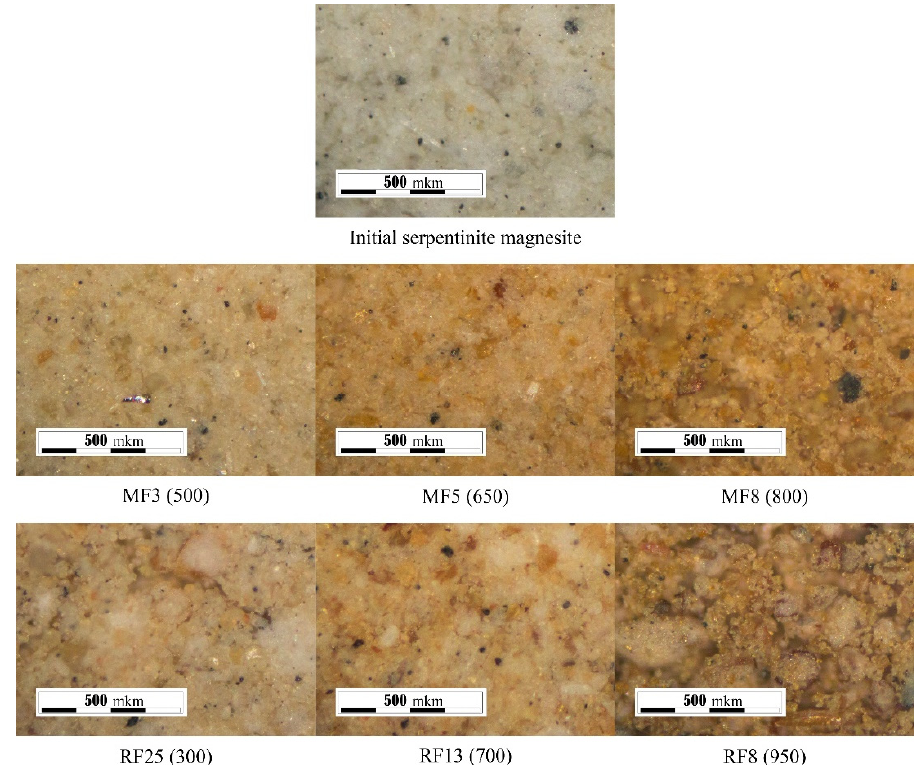
Figure 6. The appearance of serpentine samples obtained in a laboratory muffle furnace (MF) and in a laboratory rotary kiln (RF); the roasting temperature (°C) is indicated in parentheses. The appearance of serpentine samples of the RF series differed from the samples of the MF series (Figure 6); particles from the RF samples appear larger. Particle enlargement was observed during the roasting of serpentines in the industrial apparatus [41]. The par- ticle size increased due to adhesion during the stirring of the material in a rotating tem- perature chamber during heat treatment. The darkest in color sample RF8, obtained at a temperature of 950 °C included a more significant amount of dark gray particles that corresponded to magnetite; the presence of this phase in the samples of the RF series was confirmed by XRD data (Figure 1b). 3.3. Determination of the Thermally Activated Serpentine Sample Color Parameters using Various Models Firing serpentines led to a change in color characteristics (RGB, Lab). The combina- tion of these characteristics for each obtained sample corresponds to an individual HEX code, which was unique for each sample (Tables 3, 4). RGB and HEX color models do not provide an opportunity to numerically display the degree of similarity and difference be- tween the colors of samples. This opportunity is provided by the CIELAB model, namely, ∆ E. Colors with low ∆ E values can be combined into groups that have a common color name because at ∆ E < 2, the ∆ E is not perceived by the human eye [33,34].